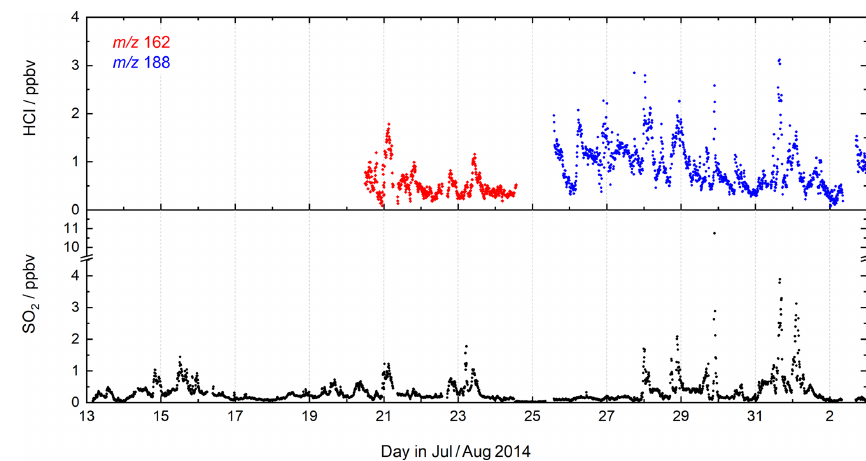
Figure 6. CI-QMS time series of SO 2 and HCl mixing ratios during the CYPHEX field campaign in